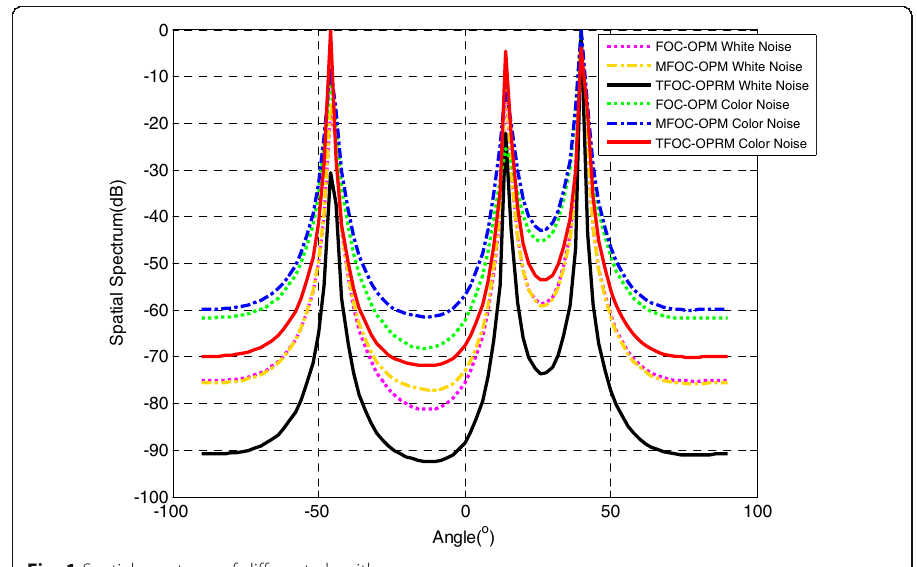
Fig. 1 Spatial spectrum of different